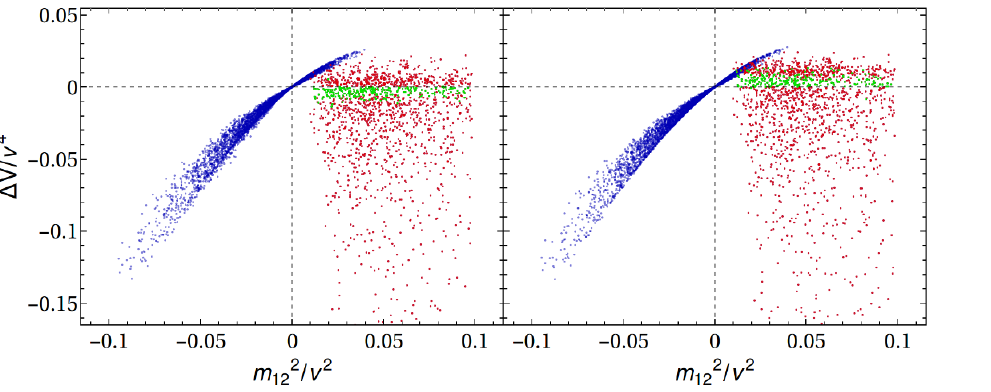
. Left : only the tree level 12